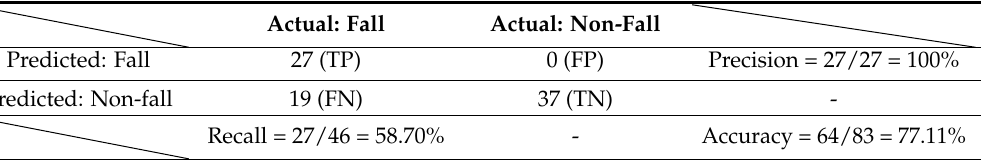
Table 3. The results from the method